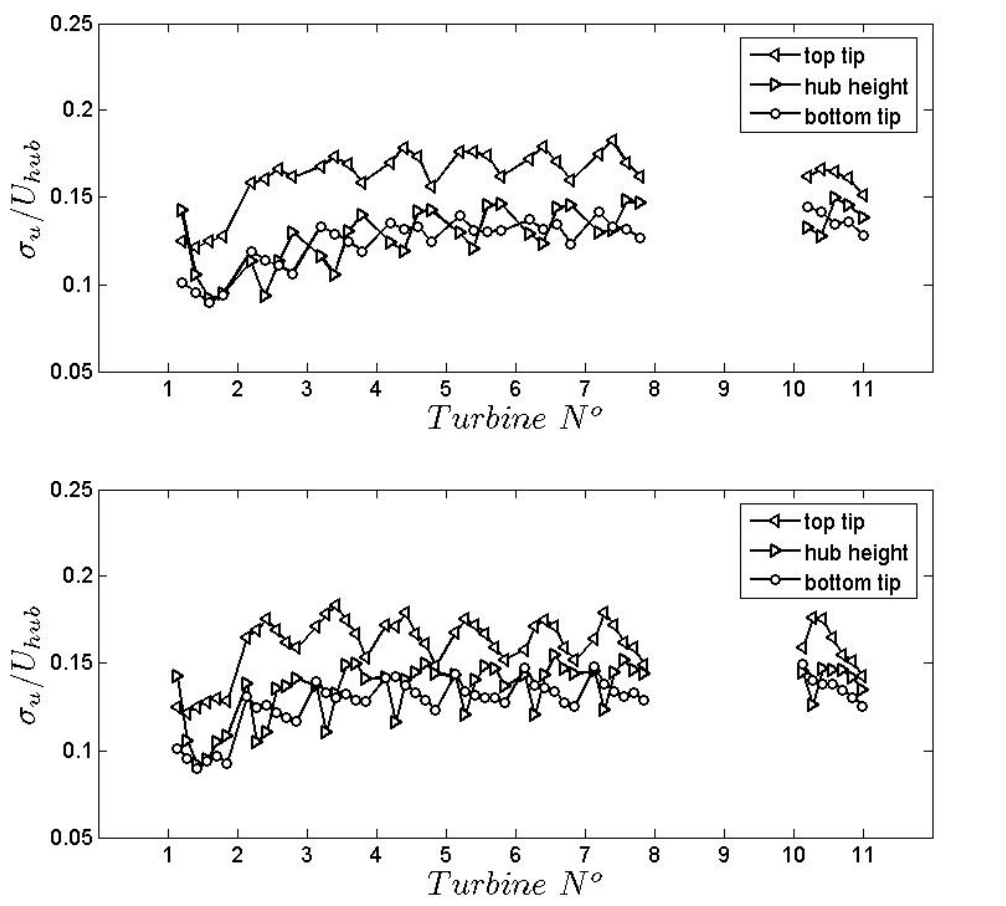
Figure 7. Turbulence intensity distribution in the wind farm at bottom, hub and top tip heights. S = 5 ( top ) and S = 7 ( bottom x x